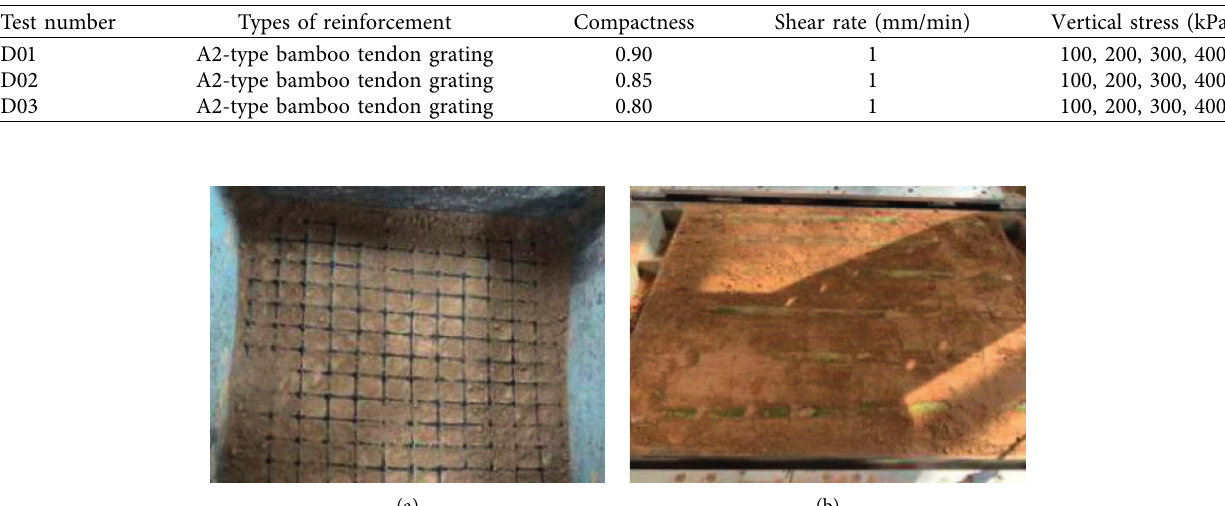
Table 9: Test schemes for different degrees of compactness.